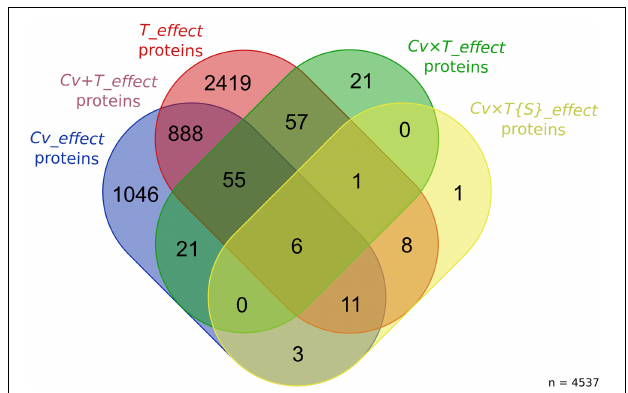
FIGURE 2 | Number of wheat proteins significantly impacted by the different effects tested in the ANOVA. The Venn diagram shows the number of wheat proteins with significant variations in abundance for each factor of the ANOVA [ Cv_effect proteins: false discovery rate (FDR) < 1%, p < 0.00026; T_effect proteins: FDR < 1%, p < 0.00045; Cv × T_effect proteins: FDR < 1%, p < 0.00002; and Cv × T{S}_effect proteins: FDR < 1%, p <